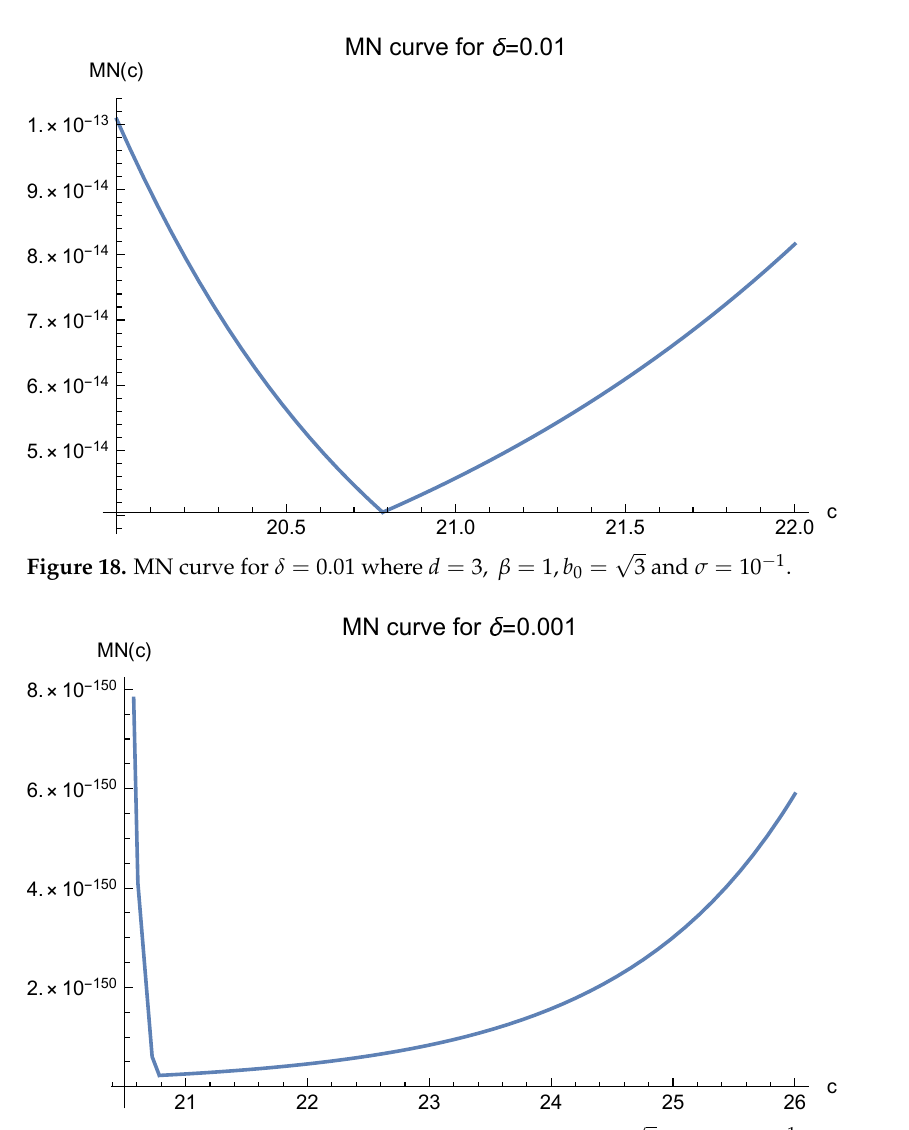
√ 3 and σ = 10 − 1 . MN curve for = 0.05 (cid:1)